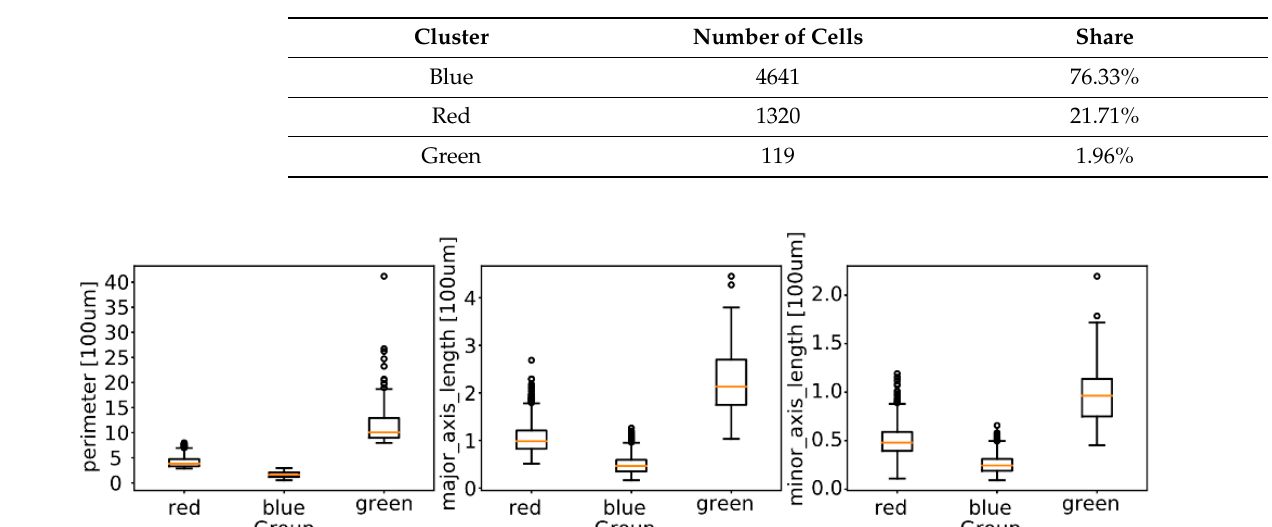
Table 3. The sizes and proportions of clusters in the feature space.